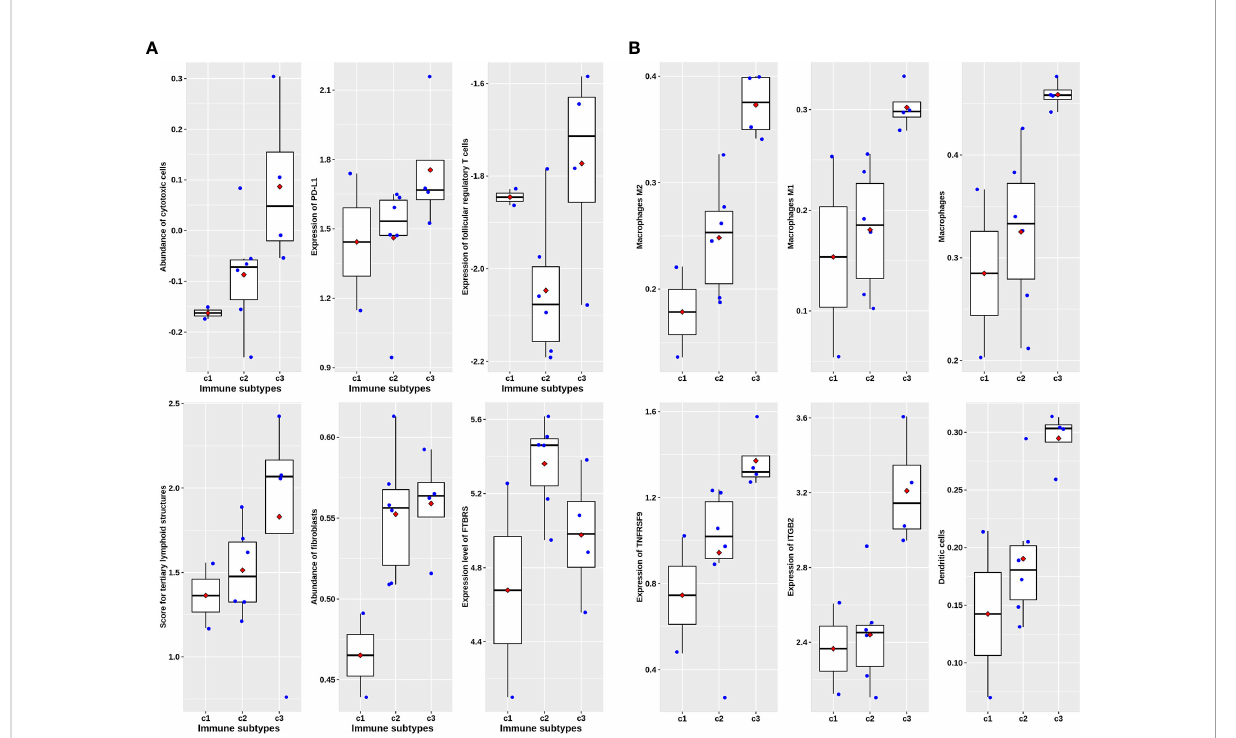
FIGURE 7 Scatter plots overlapped with box plots illustrating immune characteristics among three immune subtypes available after nCRT treatment in DPH cohort. (A) Six major immune related scores without statistical signi fi cance. (B) Six immune related scores with statistical signi fi cance revealed by Kruskal – Wallis H